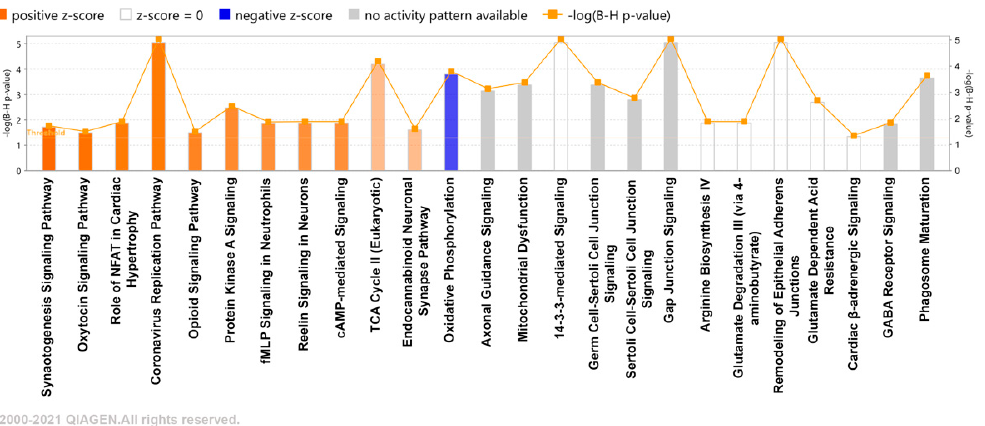
Figure 3. Ingenuity pathway analysis (IPA). Enriched pathways associated with long-term MDZ exposure. The pathways are ranked by the negative log of the FDR corrected p -value of the enrichment score and color-coded according to the Z score. A significantly increased pathway activity is indicated by a positive Z score, represented by the orange bars, and an overall decrease in pathway activity is represented by a negative Z score, represented by blue bars. The Gray bar represents enriched pathways with no predicted activity change.